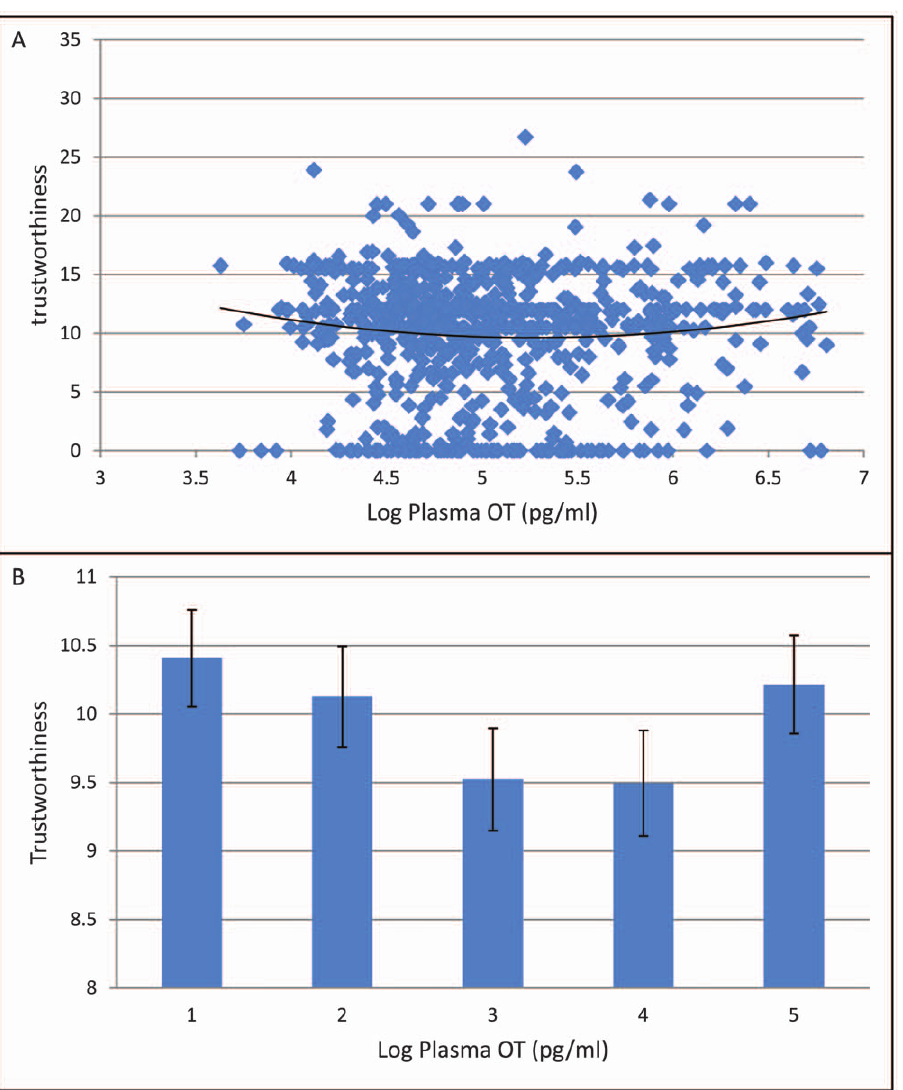
Figure 2. Plasma oxytocin and trustworthiness. (A) Scatter Plot on the relationship between plasma oxytocin and trustworthiness. (B) Histogram on the relationship between plasma oxytocin and trustworthiness.